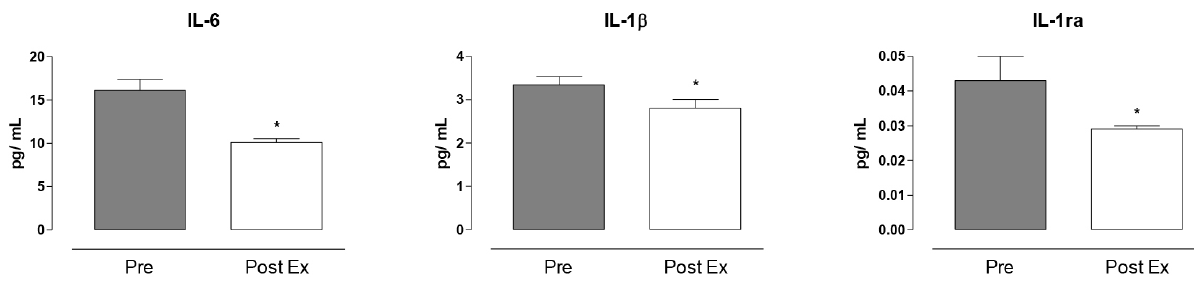
Figure 2. Cytokine concentration at baseline (filled columns) and after twenty-four weeks of moderate-intensity physical exercise (open columns) in older women. Paired t- test , data are mean ± S.E.M, n = 11. * Different from